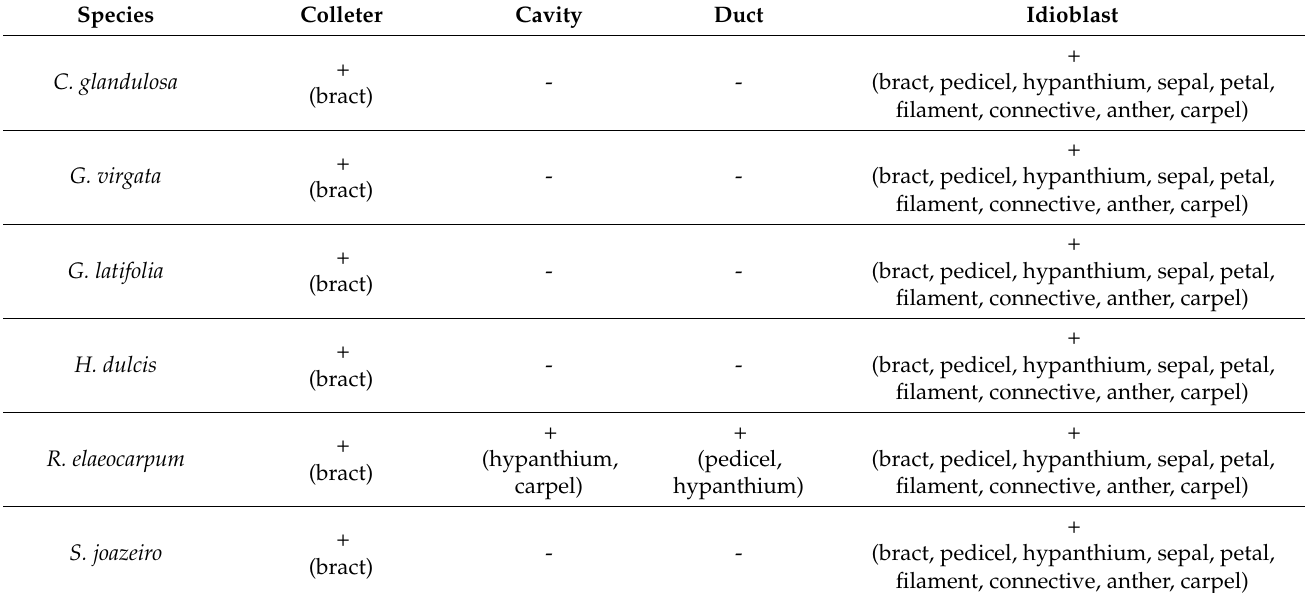
Table 1. Occurrence of secretory structures in the flowers of the studied species of Rhamnaceae. Symbols: ( − ) = absence; (+) = presence.